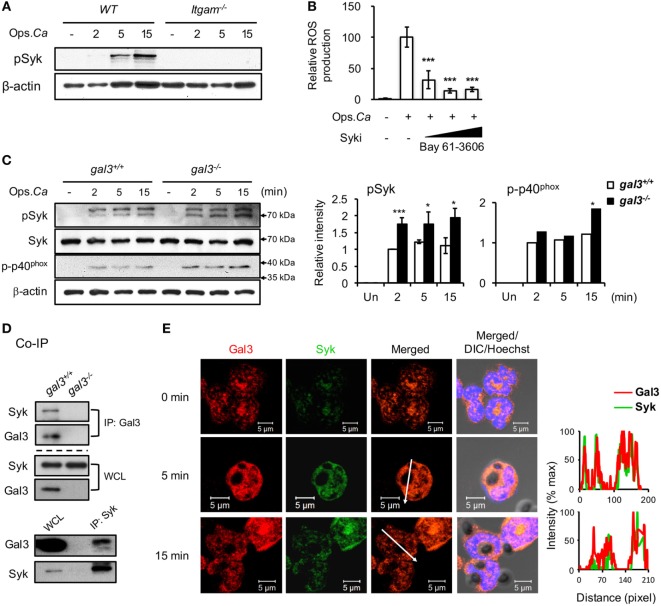
Gal3 negatively regulates complement receptor 3 downstream Syk-mediated neutrophil reactive oxygen species (ROS) response to Candida. Gal3+/+ (WT), gal3−/−, and Itgam−/− neutrophils were stimulated with opsonized Candida (Ops. Ca). (A) Cell lysates were collected at different time points after stimulation and subjected to Western blot analysis with anti-p-Syk antibody. β-actin was used as a loading control. (B) WT cells were pretreated with 2, 10, and 50 µM of Syk inhibitor before stimulation. The levels of ROS produced by neutrophils at 20 min after stimulation were analyzed by flow cytometry. Relative ROS production was calculated by dividing mean fluorescence intensity of oxidized DCF fluorescence in Candida-stimulated cells by that in untreated cells. n = 6 as pooled from two independent experiments. (C) Cell lysates were collected at different time points after stimulation and subjected to Western blot analysis with anti-p-Syk, -Syk, or -p-p40phox antibodies. β-actin was used as a loading control. Relative intensity of p-Syk (n = 5) and p-p40phox (n = 2) at different time points are shown in the right panel. Data are presented as mean ± SEM. *p < 0.05, ***p < 0.005, as analyzed by Mann–Whitney test. (D) Whole cell lysates (WCL) were immunoprecipitated with anti-gal3 (IP: Gal3, upper panel) and anti-Syk (IP: Syk, lower panel) antibodies. Precipitates were subjected to Western blot analysis with anti-Syk and anti-gal3 antibodies. Experiments were performed three times. Data from one representative experiment are shown. (E) Confocal microscopy image of gal3 (red) and Syk (green) in neutrophils after stimulation by Candida. The intensity of different fluorochromes along the white arrow in the merged image is shown in the histogram on the right. See also Figure S1 in Supplementary Material.